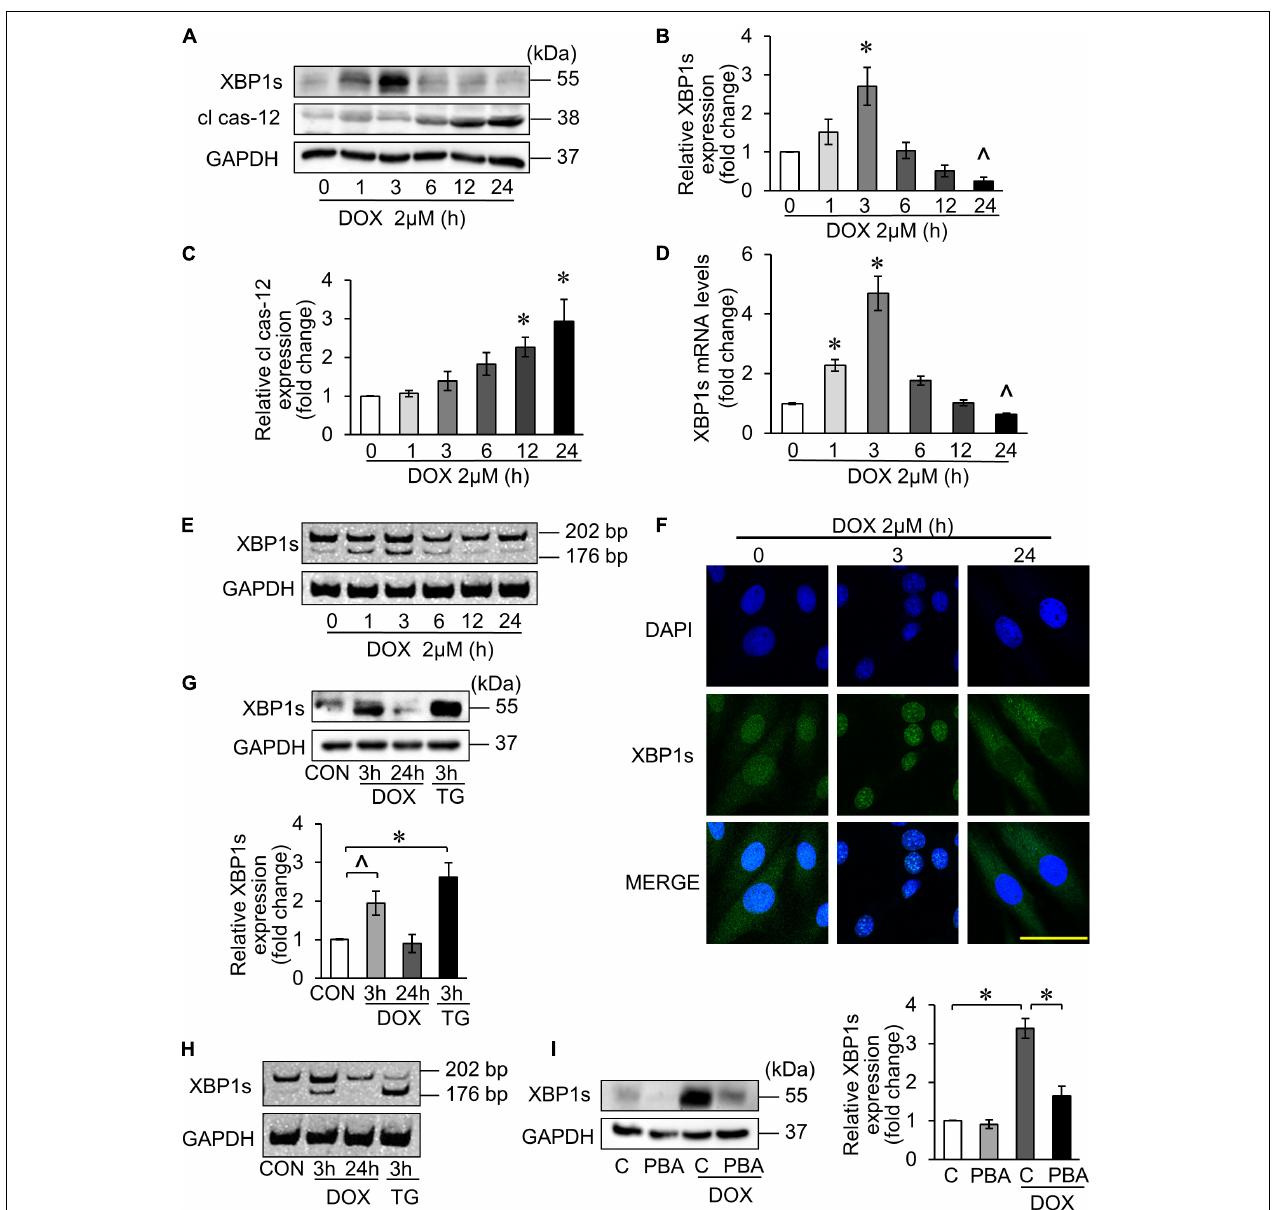
FIGURE 4 | X-box binding protein 1 (XBP1) participated in DOX-induced cardiotoxicity. (A–E) H9c2 was treated with 2 µ M DOX for the indicated times. The XBP1s levels were detected using Western blots (A) and the quantitative histogram was shown (B,C) , and also detected using qRT-PCR (D) . ∧ p < 0.05 vs. control. ∗ p < 0.01 vs. control. Spliced bands of XBP1 were detected by polyacrylamide gel electrophoresis (E) . (F) H9c2 was treated with 2 µ M DOX for 3 and 24 h. The localization of XBP1s in cells was detected by immunofluorescence experiment. Green, XBP1s; blue, DAPI-stained nuclei; scale bar, 50 µ m. (G,H) H9c2 was treated with 2 µ M DOX or 50 nM TG for the indicated times. The XBP1s levels were detected by Western blots and the quantitative histogram was shown (G) , and the spliced bands were detected by polyacrylamide gel electrophoresis (H) . TG, thapsigargin. (I) H9c2 was treated with 2 µ M DOX for 3 h, which was pre-treated with 5 mM 4-PBA for 3 h. The XBP1s levels were detected by Western blots and the quantitative histogram was shown. All the experiments have been performed independently in triplicate, and the data were expressed as mean ± SD. ∧ p < 0.05 vs. control. ∗ p < 0.01 vs.